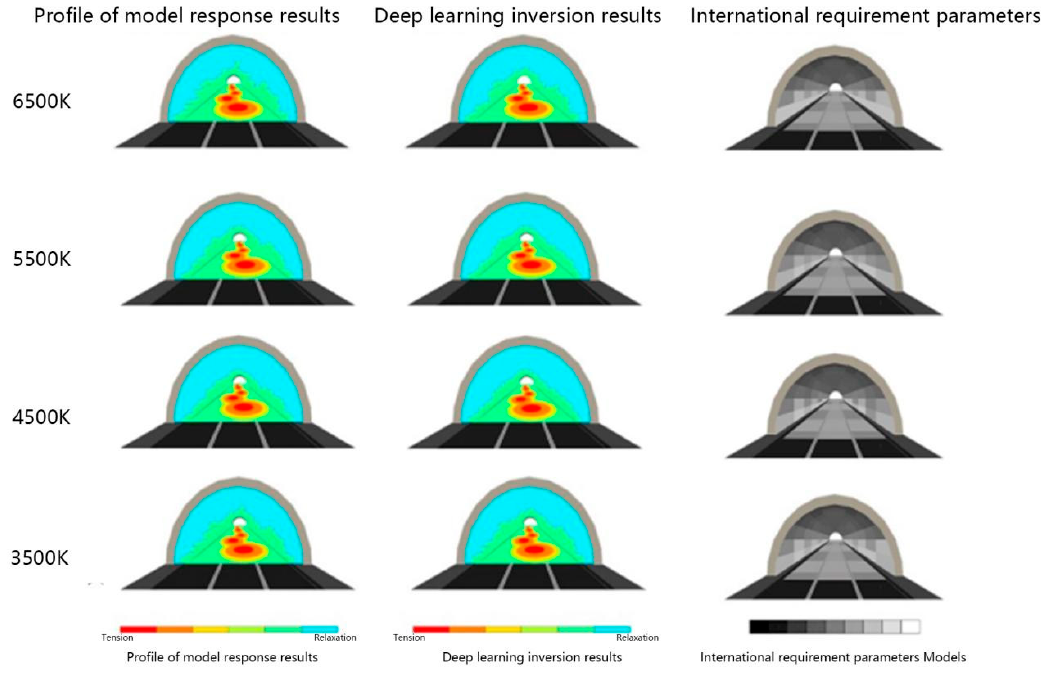
Figure 9. LED light source color temperature sensitivity analysis calculation.